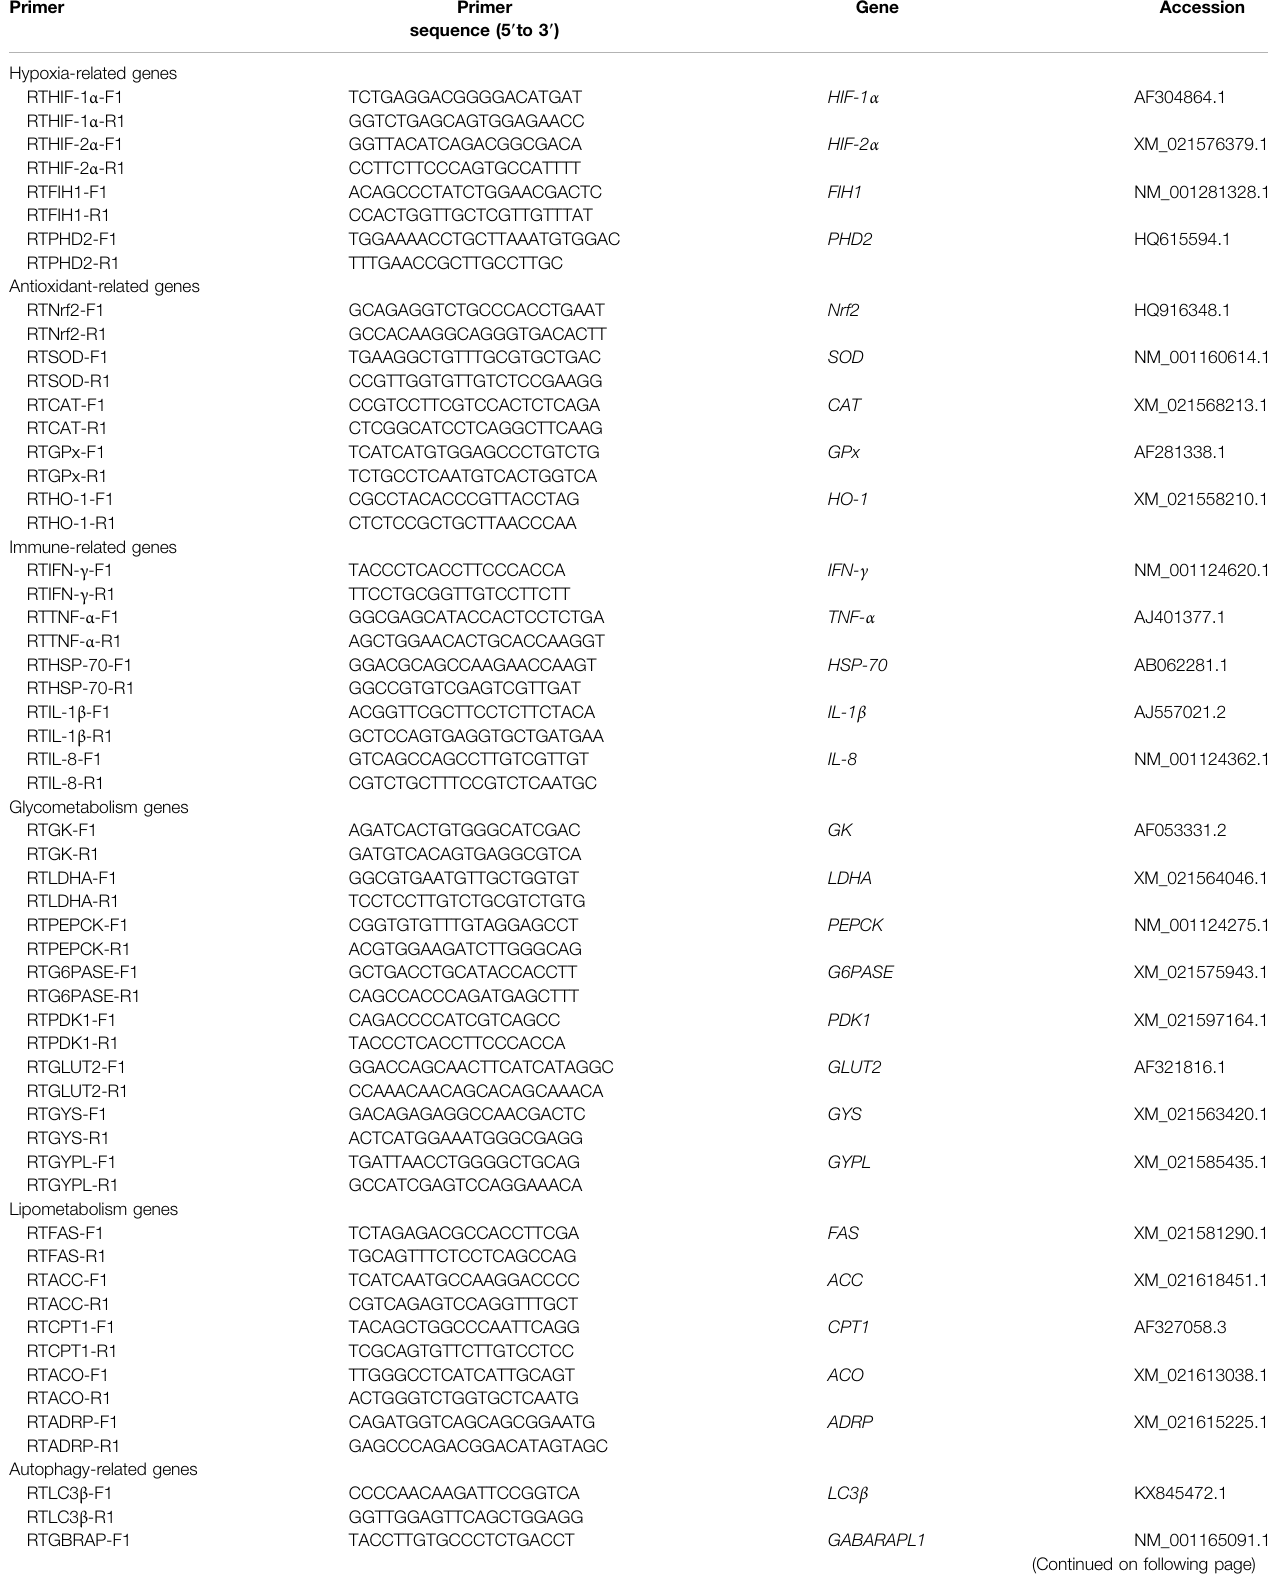
TABLE 1 | Primers used for gene expression analysis in Oncorhynchus mykiss